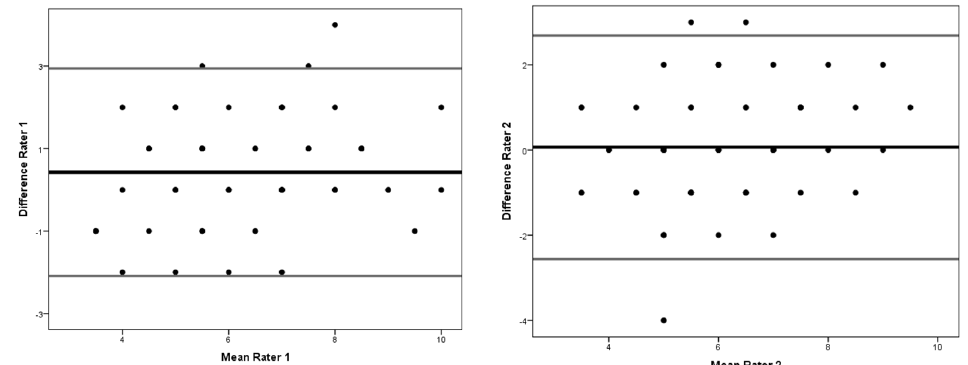
Figure 2. Bland–Altman plots to graphically show intra-rater reliability for rater 1 and rater 2, respectively. The y -axis shows the mean of the differences between the CMAS scores given in the first and second evaluations by rater 1 and rater 2, respectively, as well as the 95% confidence intervals for these means. The x -axis shows the mean of the two scores given for each of the cases analysed.